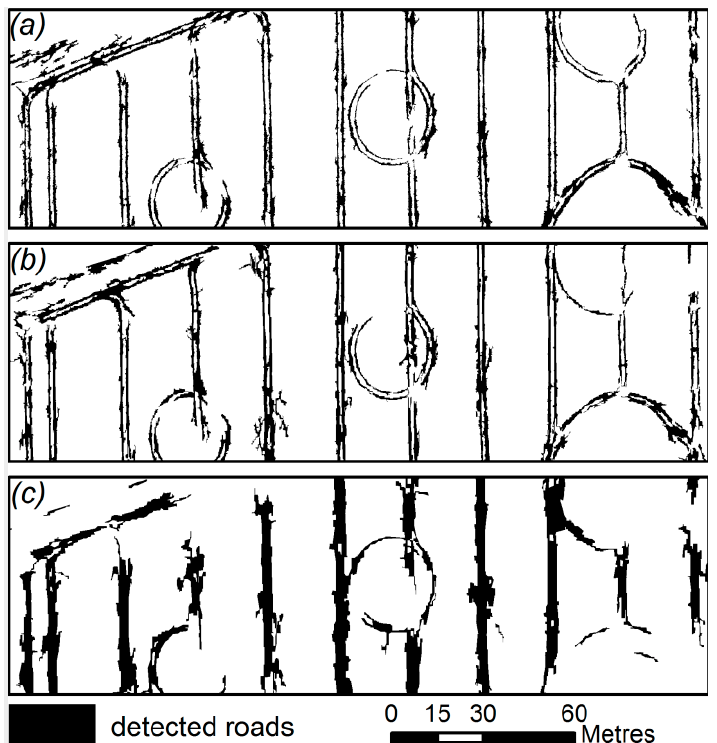
Figure 6. Detected roads on orthomosaics with ground sampling distance (GSD) of 5 cm ( a ), 10 cm ( b ), and 20 cm ( c ).